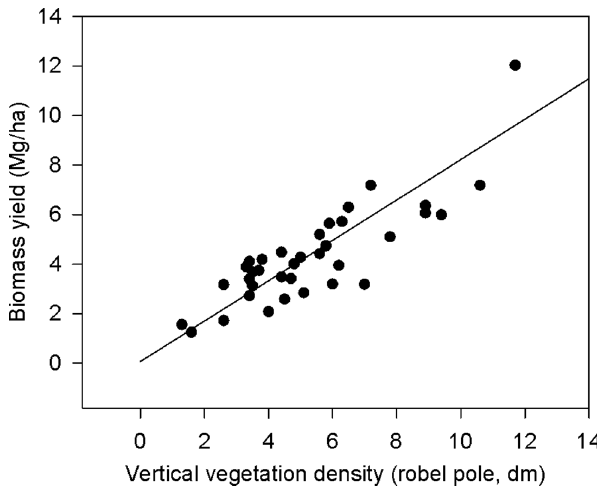
Figure 3. Relationship between biomass yield and vertical vegetation density in grassland fields. Predicted (solid line) and observed values (closed circles) are shown.